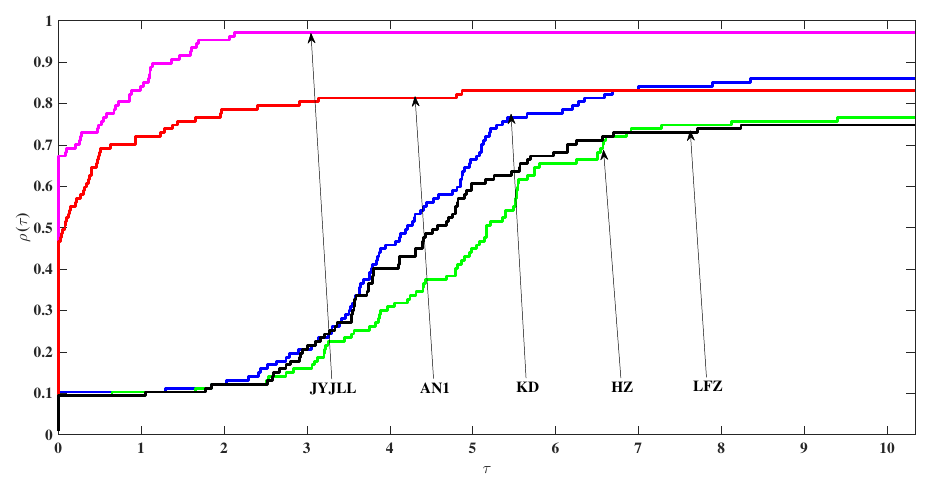
Figure 3. Performance profiles on NG